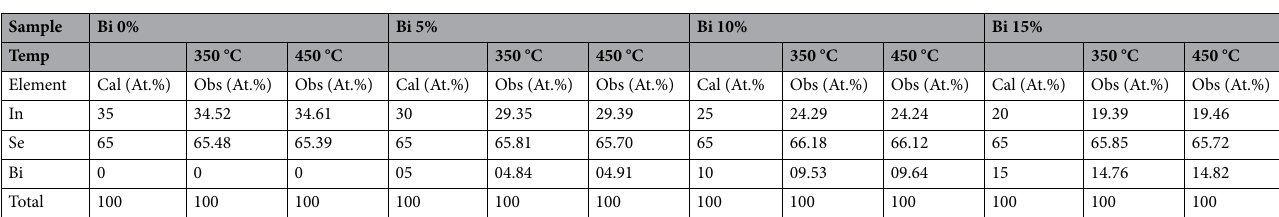
Table 2. Composition of different annealed Bi x In 35-x Se 65 (x = 0, 5, 10 and 15) thin